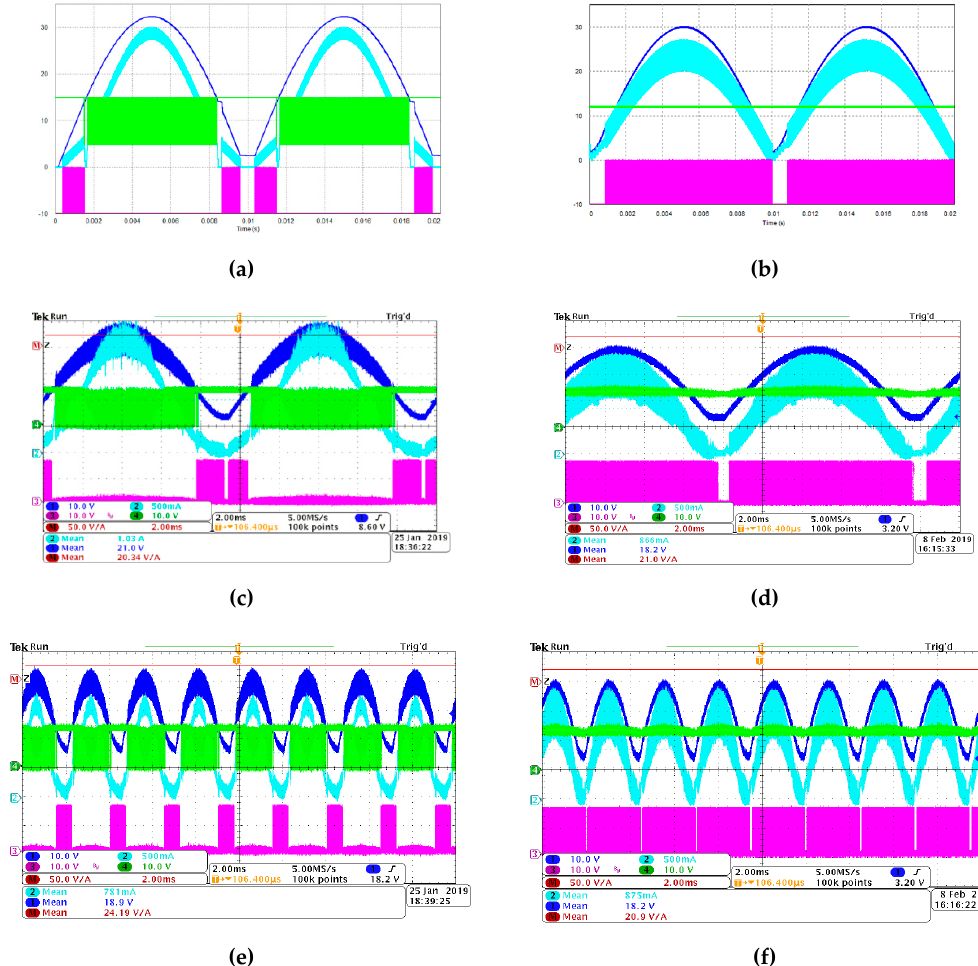
Figure 20. Simulation and experimental tests with C f = 10 μ F, and a sinusoidal input of v p ( t ) = 60 · sin(2 π f o · t) : ( a ) HBB simulation with f o = 50 Hz, ( b ) Sepic simulation with f o = 50 Hz, ( c ) HBB prototype with f o = 50 Hz, ( d ) Sepic prototype with f o = 50 Hz, ( e ) HBB prototype with f o = 200 Hz, and ( f ) Sepic prototype with f o = 200